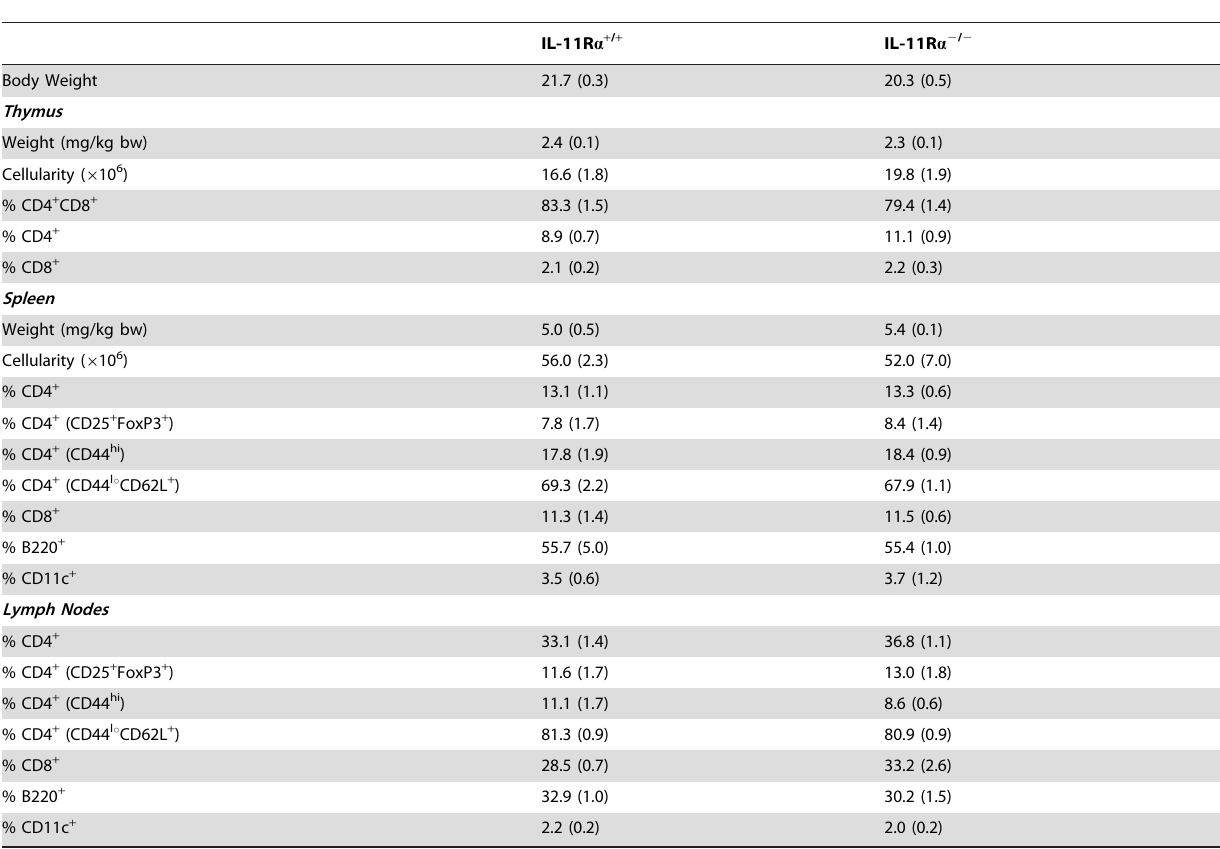
Table 1. Characterization of the T Cell Compartment in IL-11R a + / + and IL-11R a 2 / 2 Mice.